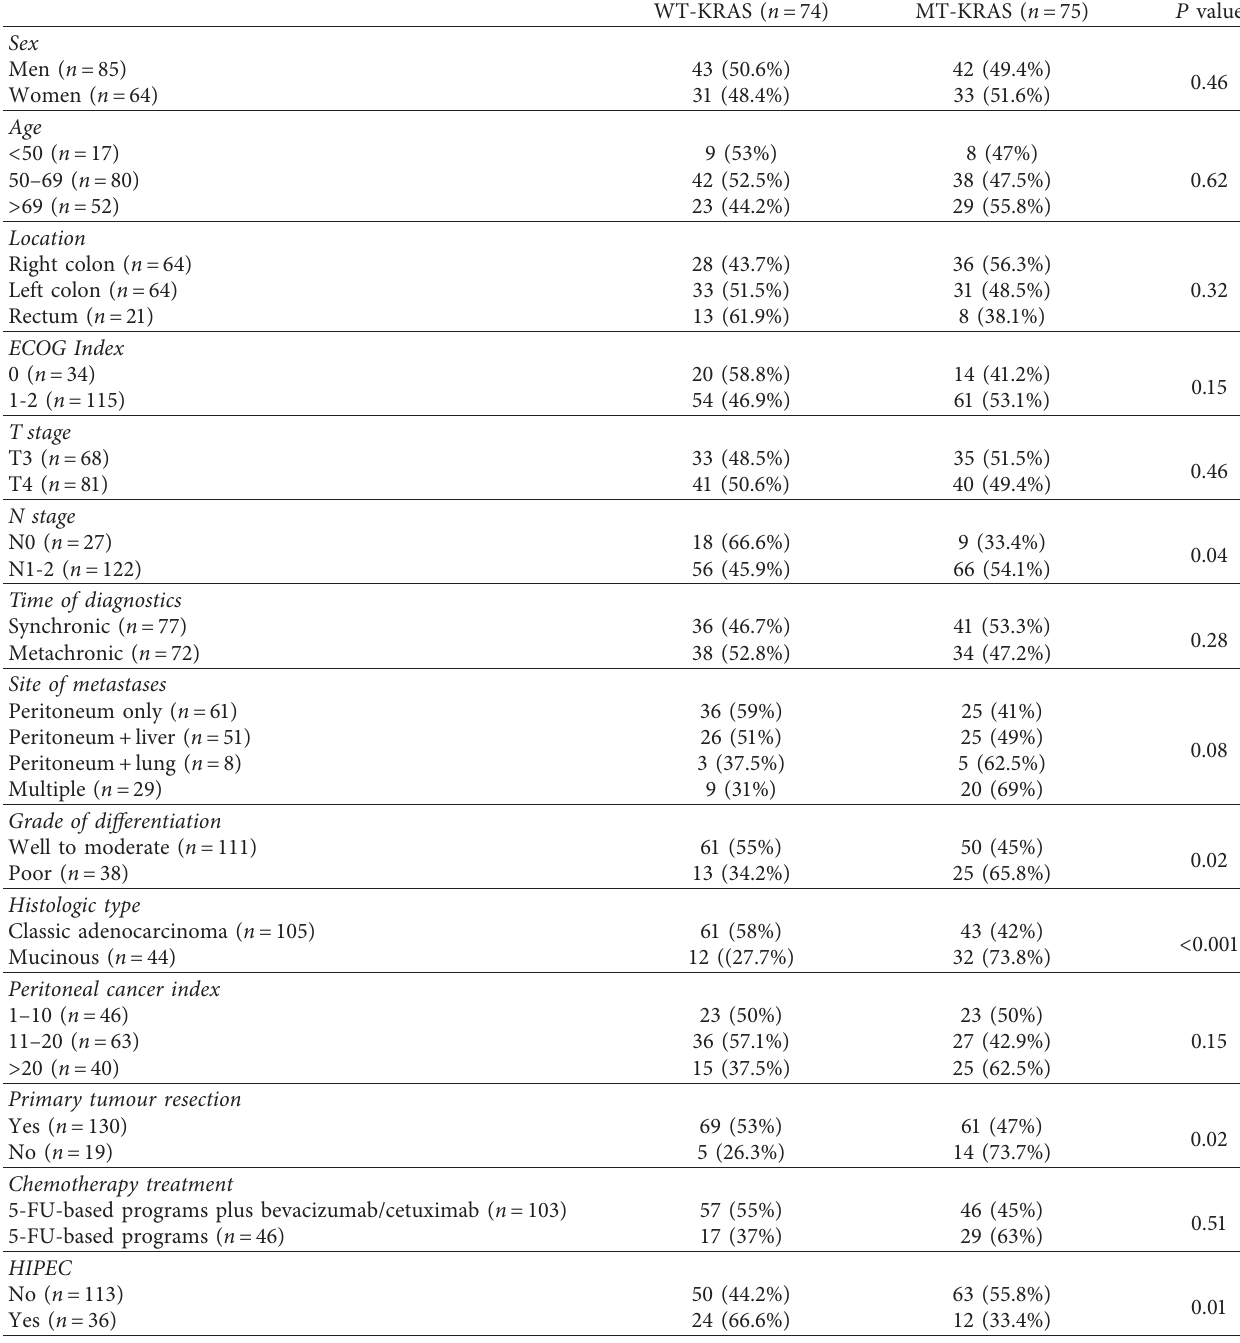
Table 2: KRAS mutation status according to patient and tumour characteristics.